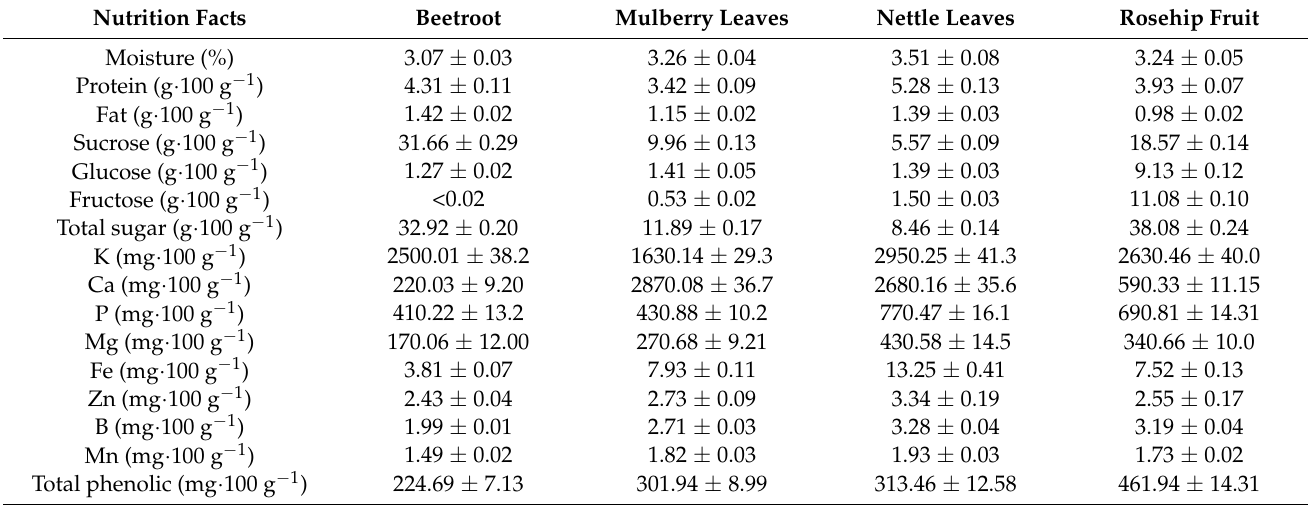
Table 2. Nutrition facts of Greek-style yogurt.